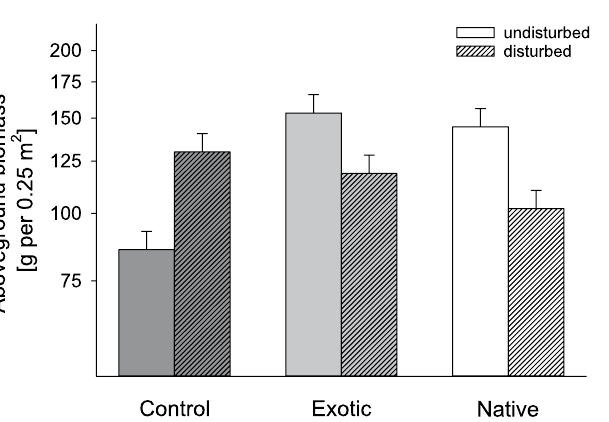
Figure 5. Effect of species origin (control = no seed addition, exotic = exotic seed addition, native = native seed addition) and disturbance (undisturbed, disturbed) on aboveground biomass. Data shown are least square means of repeated-measure linear mixed models ± SE averaged across two years. Note that aboveground biomass is given on a logarithmic